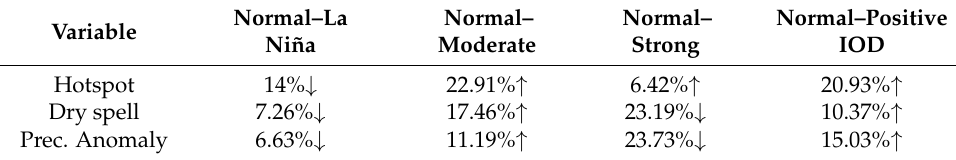
Table 2. Thailand—difference value of the PDF from years categories.